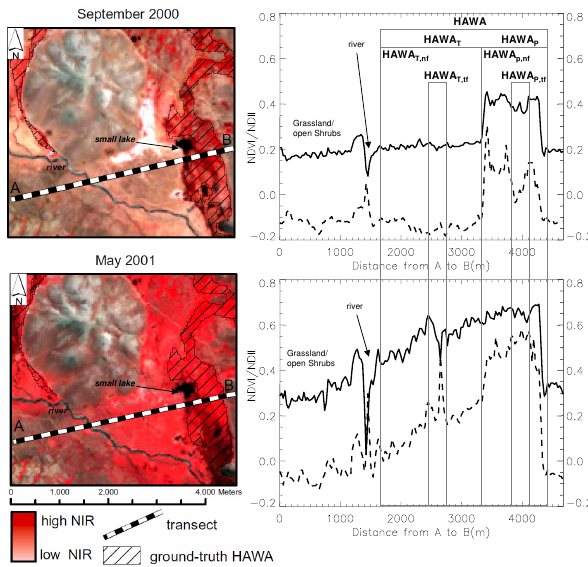
Fig. 4. Left side Landsat ETM+ image in false colour mode (band order 4, 3, 2 in RGB) of ground-truth site upper River Coater (left side) together with corresponding NDVI (solid line) and NDII (dashed line) transects (diagrams on the right side) of Septem- ber 2000 (above) and May 2001 (below). Grey frames within in the diagrams indicate different HAWA subclasses as described in the